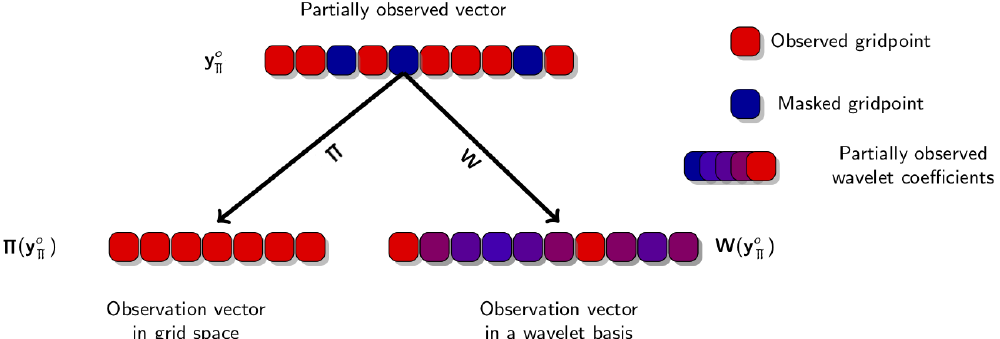
Figure 4. Schematic representation of the impact of non-observed pixels on the observation vector for both “pixel-grid" space and wavelet space. In pixel-grid space, missing pixels simply disappear. In wavelet space, missing pixels lead to partially observed wavelets